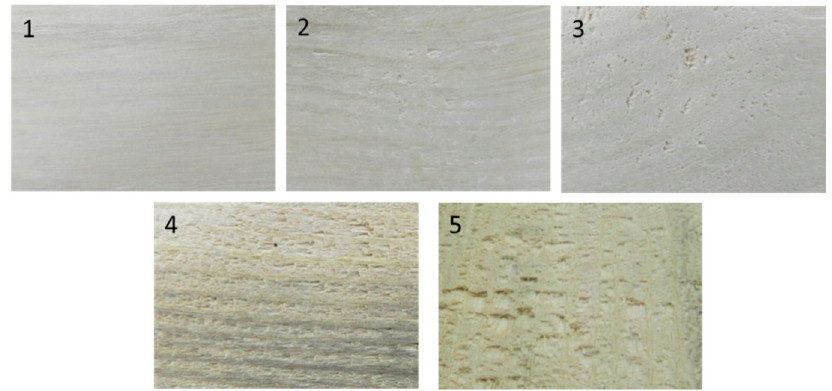
Figure 3. Planing surface quality—torn grain: Grades 1 to 5 (Grade 1—excellent, Grade 2—good, Grade 3—fair, Grade 4—poor and Grade 5—very poor).